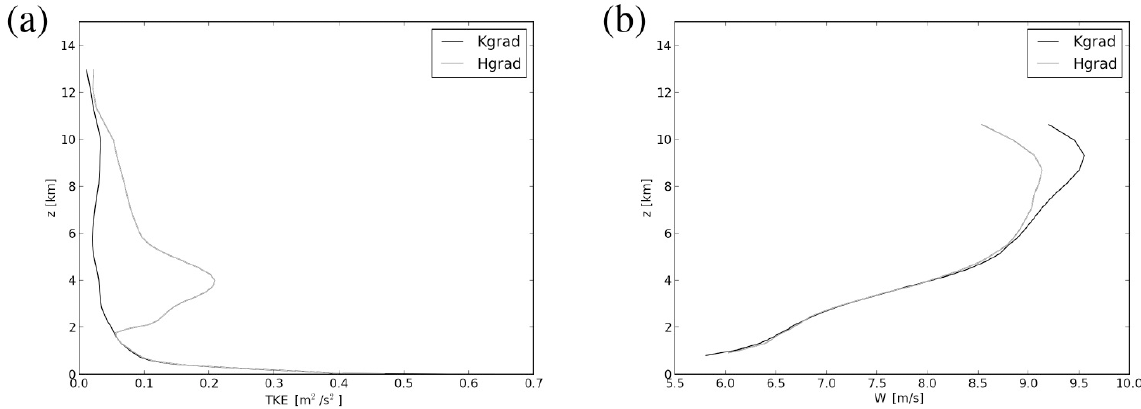
Figure 8. Mean vertical profiles inside the clouds of (a) subgrid TKE (m 2 s − 2 ) and (b) vertical velocity (ms − 1 ) during IOP16 (between 00:00UTC on 26 October and 00:00UTC on 27 October 2012) for 2km horizontal resolution Meso-NH simulations using K-gradient formulation (black line) and H-gradient formulation (grey line) for the vertical turbulent fluxes of heat and